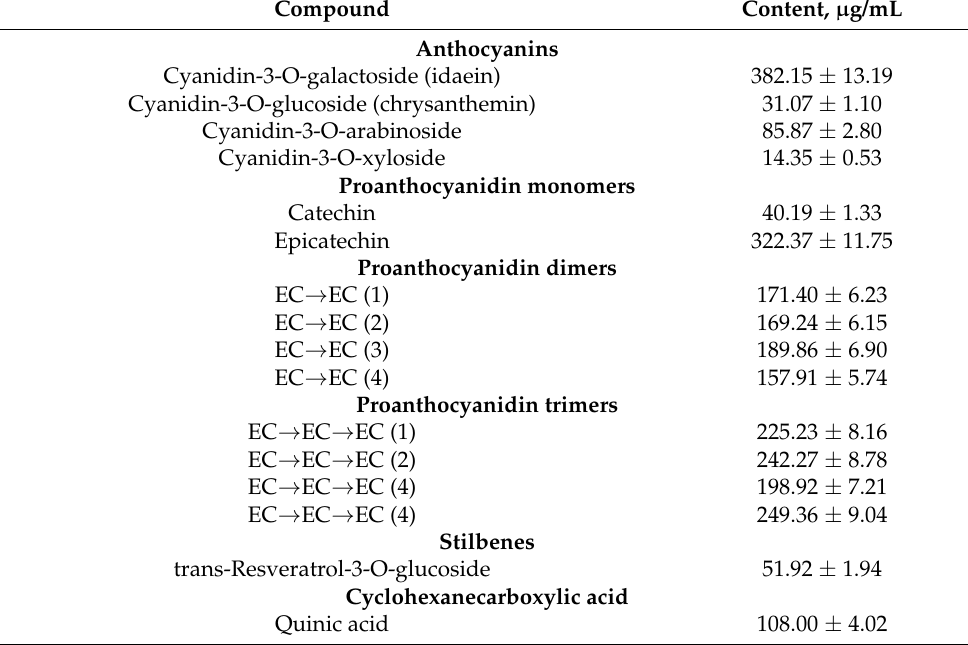
Table 2. Polyphenolic compounds identified in non-anthocyanin fraction (B) and anthocyanin fraction (C) of the SE FAE using LC-PDA-ESI-MS/MS technique. The concentrations are given in µ g/mL extract. Results are presented as mean ± standard